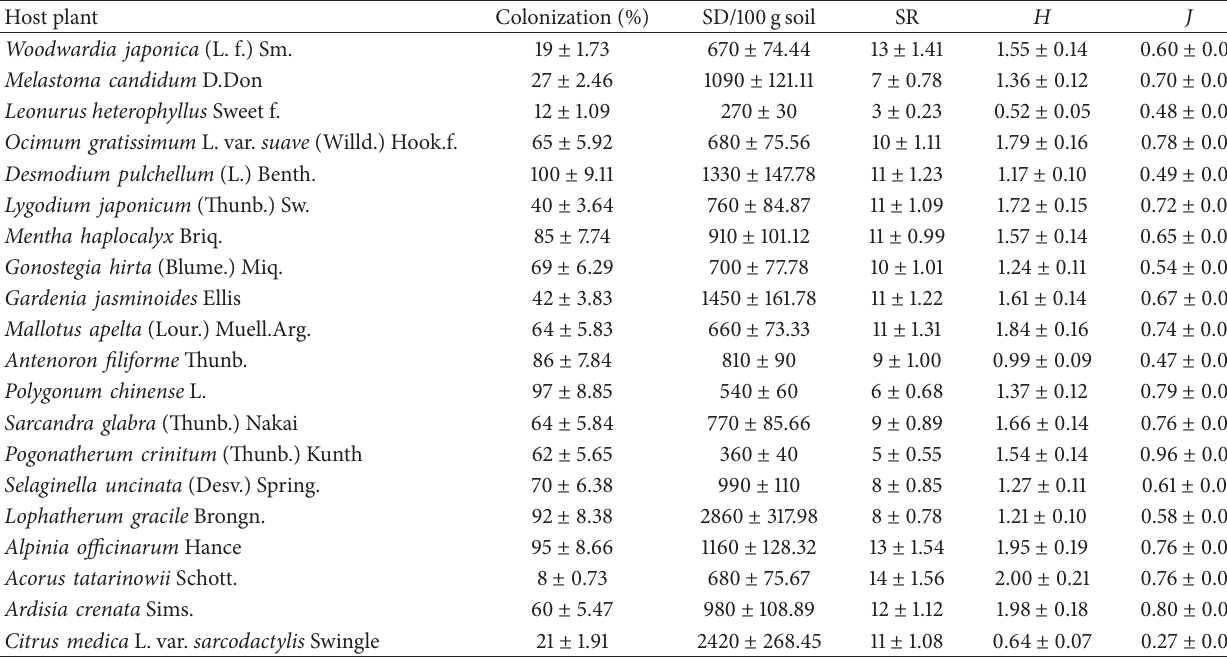
Table 3: The AM colonization and diversity index of 20 species of medicinal